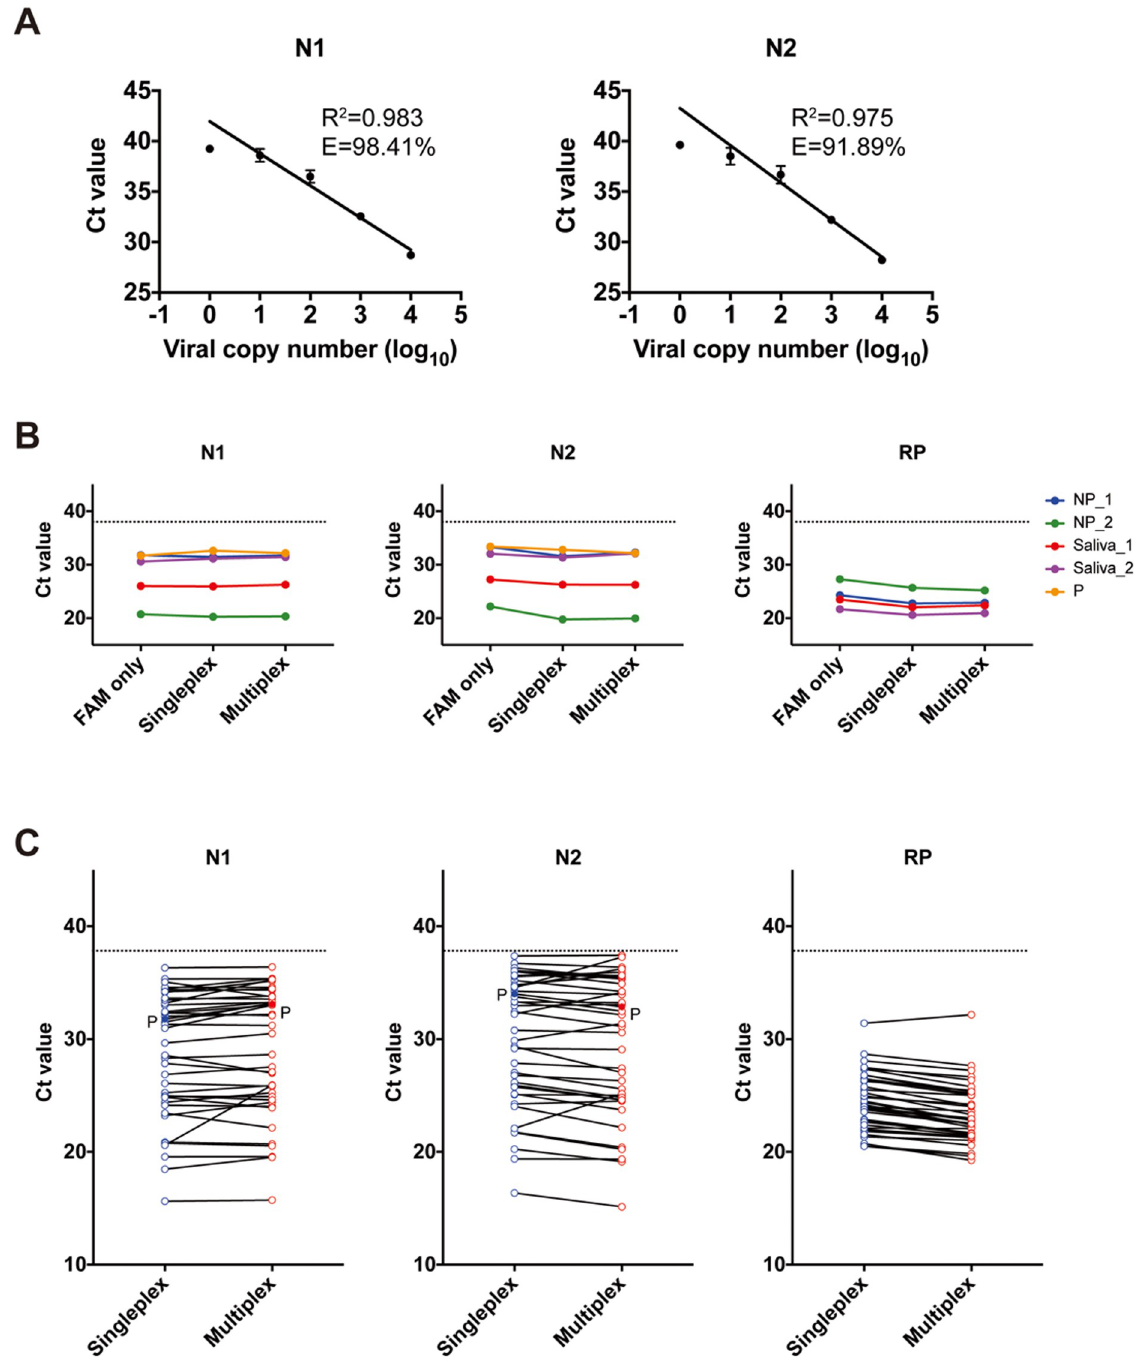
Fig 1. The qualification of multiplex RT-qPCR for SARS-CoV-2 compared with single RT-qPCR. (A) Multiplex RT-qPCR detection of SARS-CoV-2 N1 and N2 genes was validated using 10-fold dilutions of viral RNA into pooled negative NP samples. We measured sensitivity and efficiency for 20 replicates. Data are mean ± SD. Individual values are indicated in Table 1. (B) The Ct values for 4 independent COVID- 19 inpatients’ NP ( n = 2) or saliva ( n = 2) samples, 1 negative control, and 1 positive control (P) (10 3 virus copies/ μ l) were compared between single RT-qPCR (FAM only), multicolor single RT-qPCR (Singleplex), and multiplex RT-qPCR (Multiplex). The dotted line indicates the cutoff Ct value of 38. Negative control was undetectable. Individual values are indicated in Table 2. (C) Forty-two RNA templates from NP swabs and saliva samples obtained from COVID-19 inpatients or healthcare workers and positive control (P) (10 3 virus copies/ μ l) were investigated via single and multiplex RT-qPCR. The dotted line indicates the cutoff Ct value of 38. Individual values are indicated in Table 3.